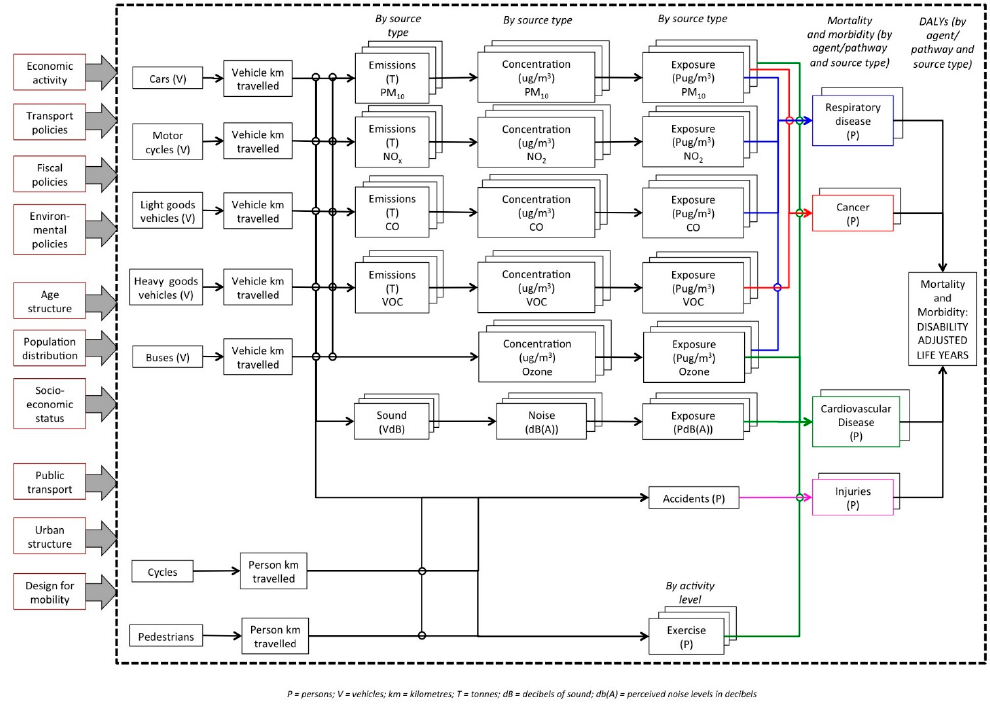
Figure 1. Scoping of the road transport-health system.